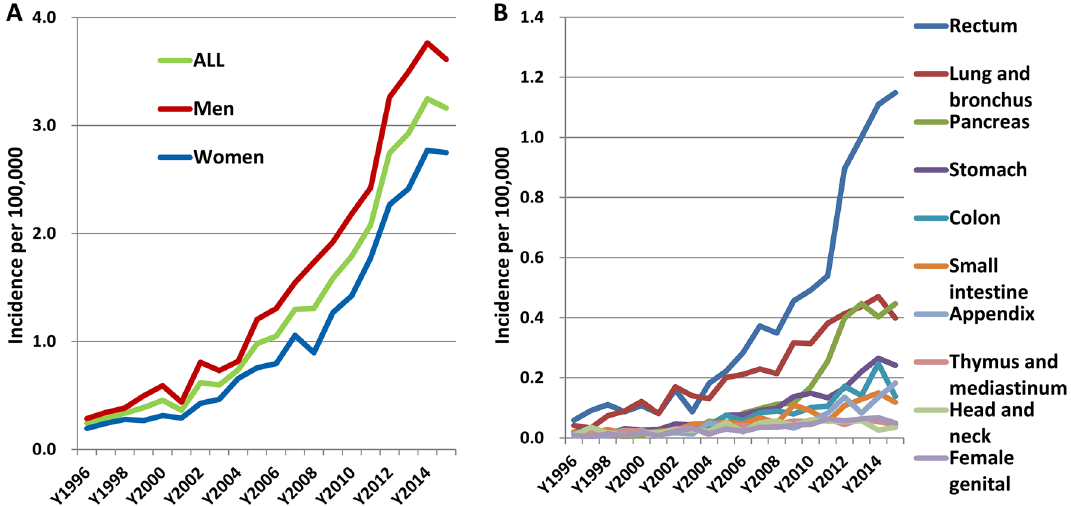
Figure 1. The annual incidence of NETs in Taiwan from 1996 to 2015. ( A ) The annual incidence of NETs of all sites in men, women and both. ( B ) The annual incidence of NETs in the 10 most common sites of NETs. Age- standardized incidence rates were calculated by direct standardization to the age distribution of the 2000 WHO standard